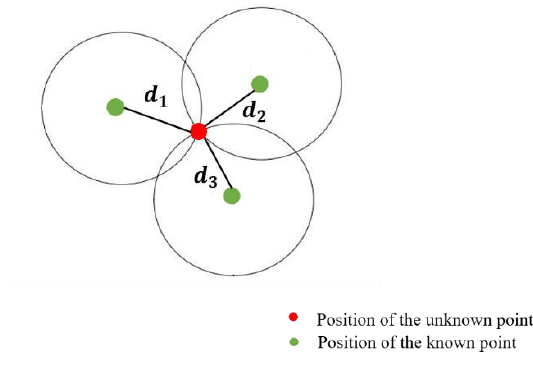
Figure7. The concept of the trilateration